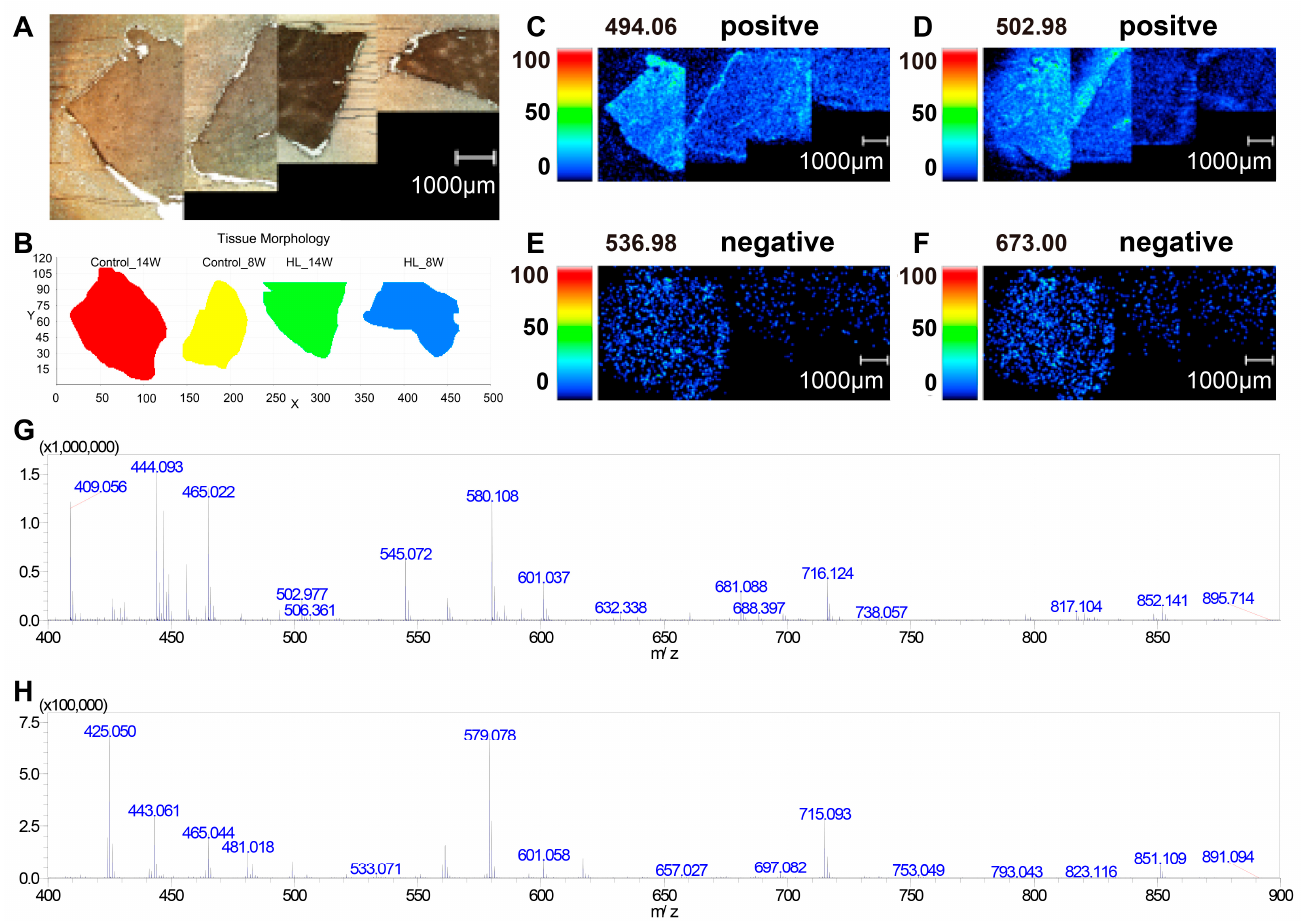
Figure 3. MSI intensity images for various m / z values and mass spectrum in liver tissues. ( A ) The optical images from left to right are Control_14w (control 14 weeks), Control_8w (control 8 weeks), HL_14w (high-lipid 14 weeks), and HL_8w (high-lipid 8 weeks). ( B ) The simulation diagram of the sample; the sequence of samples from left to right is the same as that in ( A ). ( C ) The representative MSI of positive ion mode was m / z 494.06; the sequence of samples from left to right is the same as that in ( A ). ( D ) The representative MSI of positive ion mode was m / z 502.98; the sequence of samples from left to right is the same as that in ( A ). ( E ) The representative MSI of negative ion mode was m / z 536.98; the sequence of samples from left to right is the same as that in ( A ). ( F ) The representative MSI of negative ion mode was m / z 673.00; the sequence of samples from left to right is the same as that in ( A ). ( G ) Mass spectrum in positive ion mode. ( H ) Mass spectrum in negative ion mode. The bar scale is 1000 μ m.